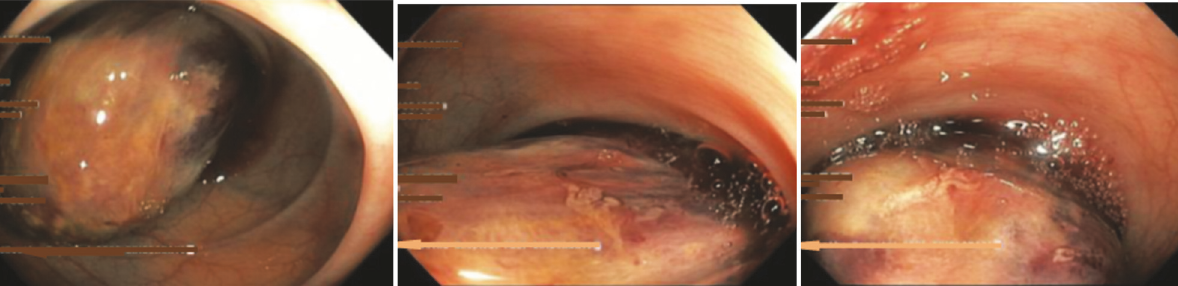
Figure 1: Endoscopic finding.